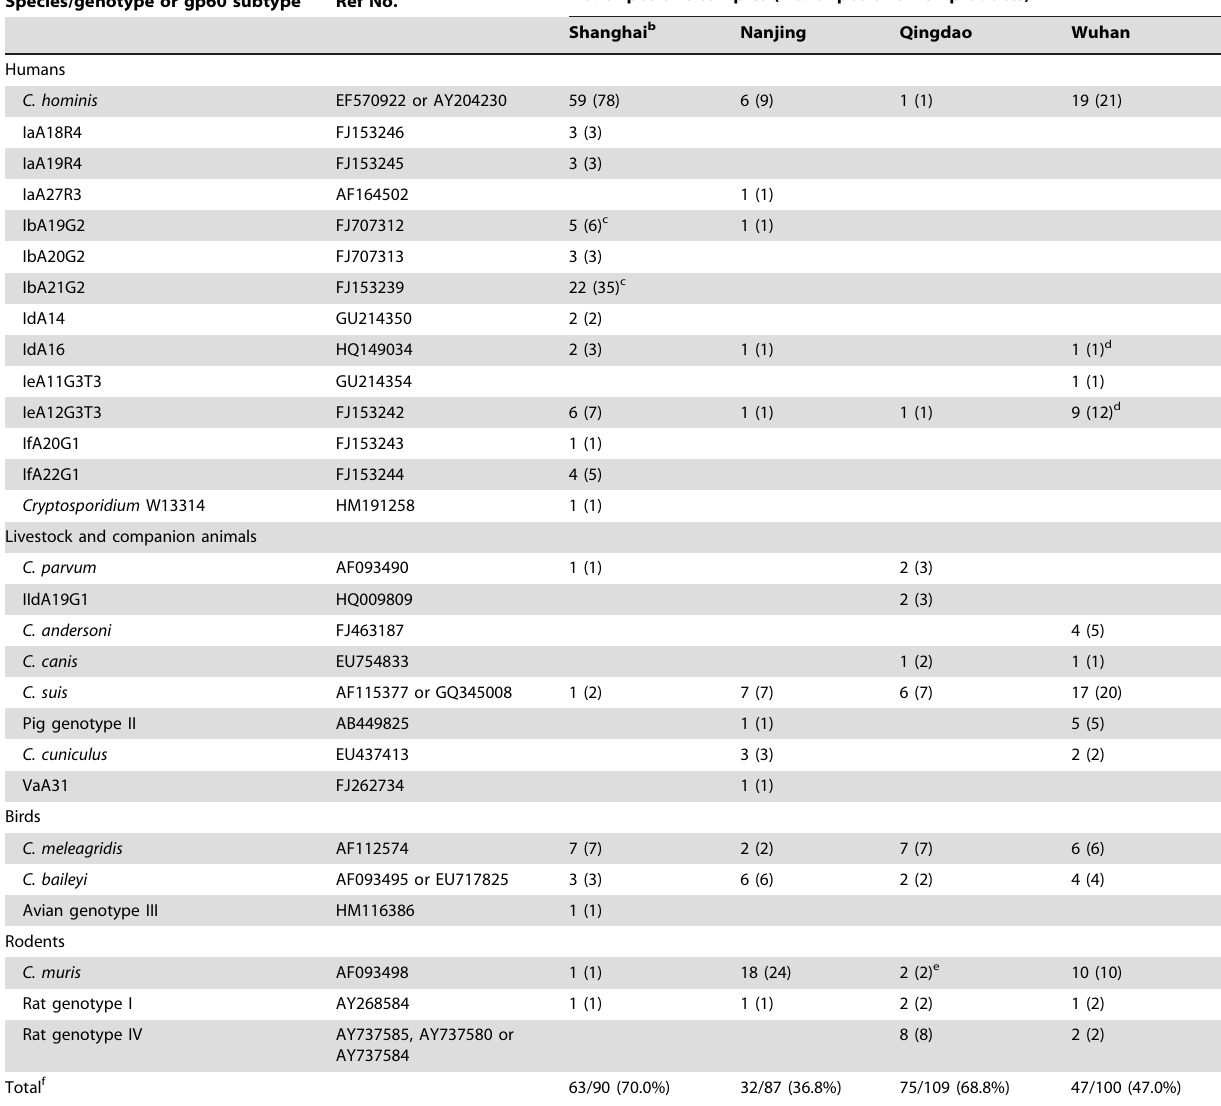
Species/genotype or gp60 subtype Ref